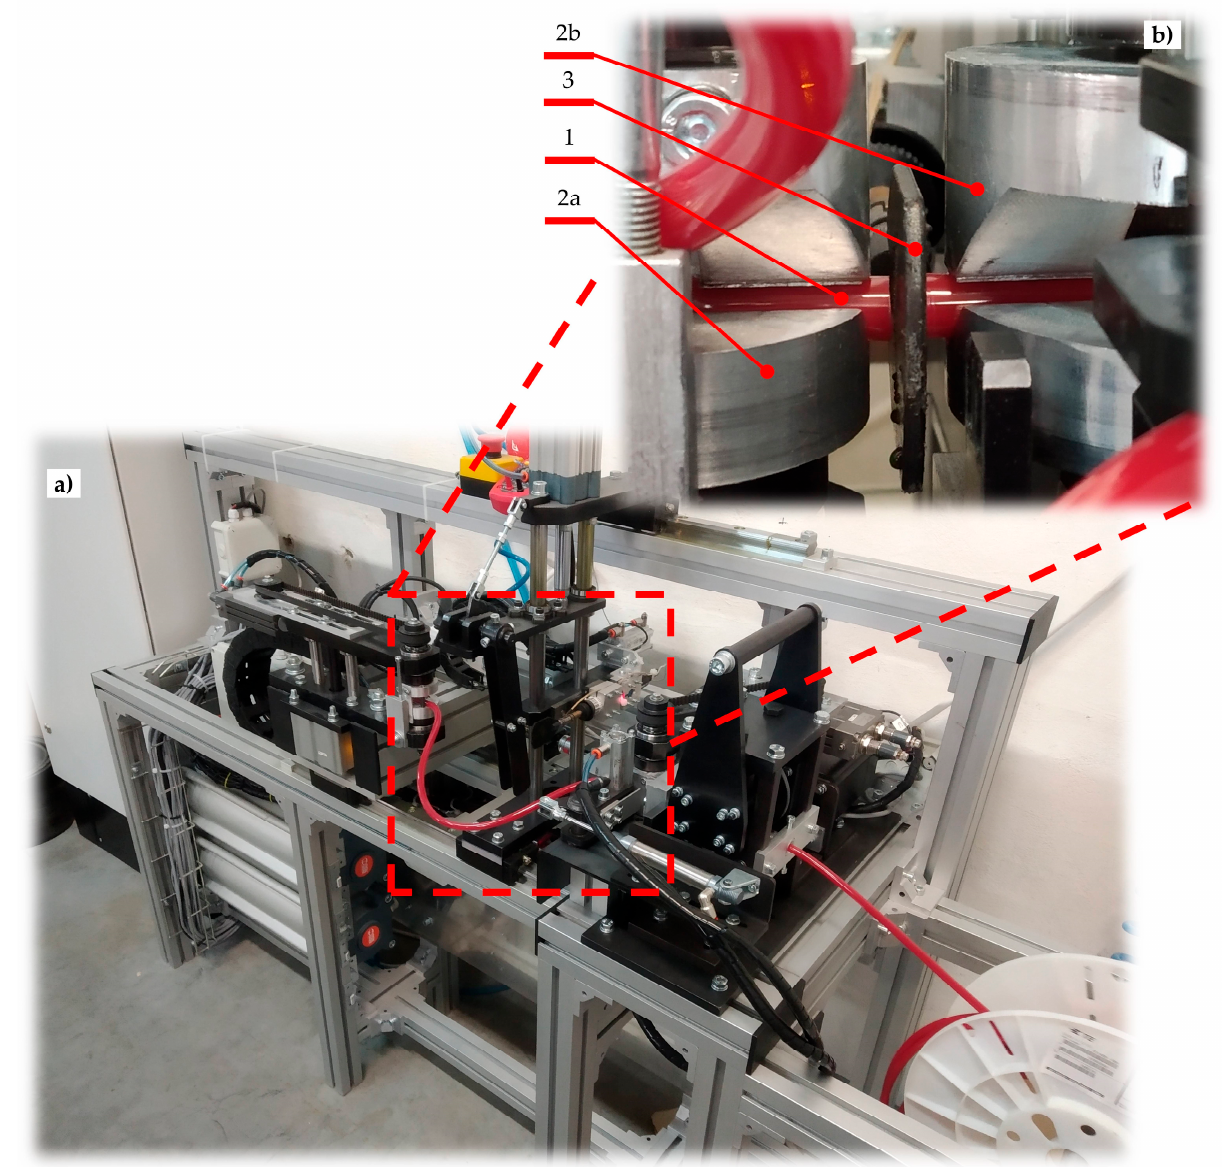
Figure 5. Automatic welding machine during butt welding of polyamide drive belt: ( a ) overview during belt dosing, ( b ) focus on the hot plate unit during the plasticization process; 1—belt, 2a—grips of the movable belt holder, 2b—grips of the fixed belt holder, 3—hot plate.